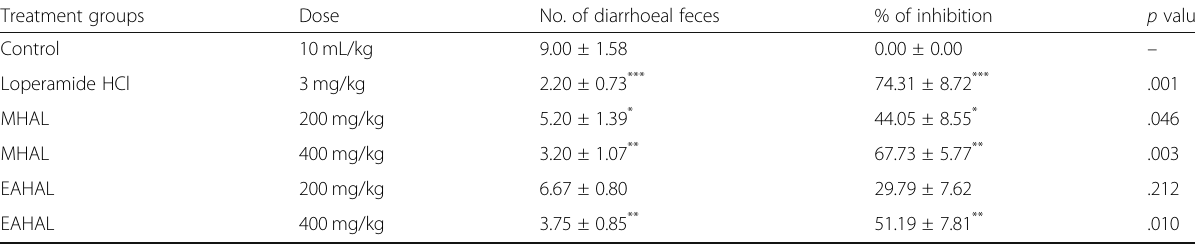
Table 6 Effect of standard and MHAL and EAHAL in Castor oil induced diarrhoeal model Treatment